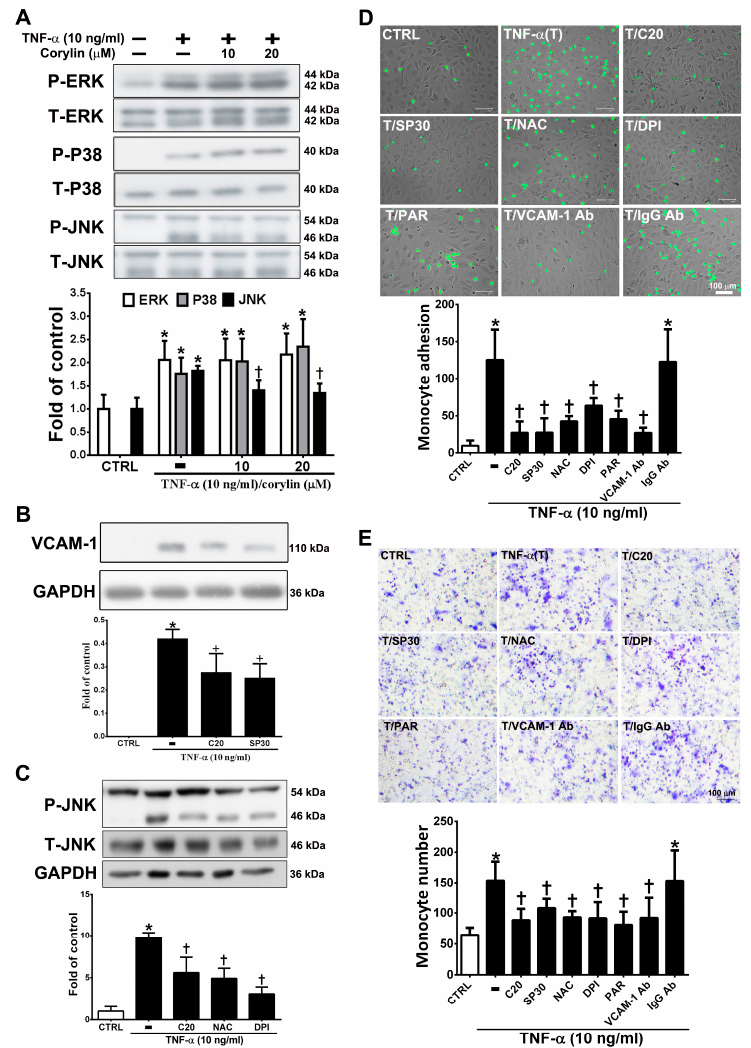
Figure 3. Corylin reduces monocyte adhesion and transmigration in TNF- α -treated HUVECs through inhibiting the ROS / JNK signaling pathway. HUVECs were treated with 20 µ M corylin for 1 h and then incubated with or without 10 ng / mL TNF- α for 15 min. Phosphorylated ( A ) ERK, P38, and JNK levels were examined by Immunoblot analysis. Total ERK (T-ERK), total P38 (T-P38), and total JNK (T-JNK) were used as an internal control for sample loading. ( B ) HUVECs were pretreated (1 h) with corylin (20 µ M; C20) and a JNK inhibitor (SP600125; 30 nM; SP30) and then treated with 10 ng / mL TNF- α for 24 h. VCAM-1 expression was analyzed by Western blotting analysis. GAPDH was analyzed in parallel as an internal control for protein loading. ( C ) HUVECs were pretreated (1 h) with corylin (20 µ M; C20) and antioxidants (NAC; DPI) and then treated with 10 ng / mL TNF- α for 15 min. Phosphorylated JNK expression was analyzed by Western blotting analysis. T-JNK or GAPDH was analyzed in parallel as an internal control for the protein loading. ( D ) Confluent HUVECs were pretreated (1 h) with 20 µ M corylin (C20), 30 nM SP600125 (SP30), 5 mM NAC, 5 µ M DPI, 10 µ M parthenolide (PAR), and 1 µ g / ml anti-VCAM-1 antibody or IgG and then with 10 ng / mL TNF- α (T) for 24 h. BCECF / AM-labeled U937 cells were added and cocultured for another 1 h. The adherent U937 cells were counted to evaluate the overall VCAM-1 expression level. ( E ) HUVECs were pretreated (1 h) with 20 µ M corylin or 30 nM SP600125 (SP30), 5 mM NAC, 5 µ M DPI, 10 µ M parthenolide (PAR), and 1 µ g / mL anti-VCAM-1 antibody or IgG and then treated with 10 ng / mL TNF- α for 24 h. U937 cells were added to the upper well for another 6 h; then, the transmigrated U937 cells were stained and counted. The data are shown as the mean ± SD. * p < 0.05 versus the untreated group (CTRL). † p < 0.05 versus the TNF- α -treated group. Scale bars = 100 µ m ( E